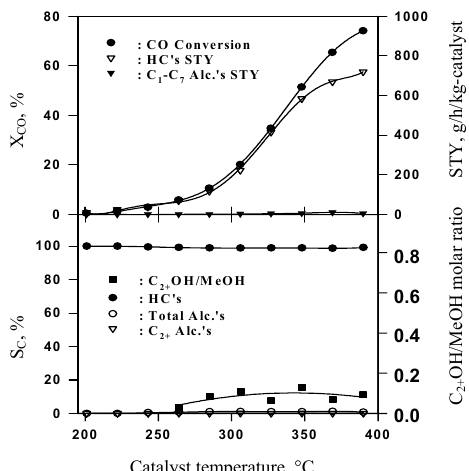
Figure 9 that the catalyst without potassium doping is very active for